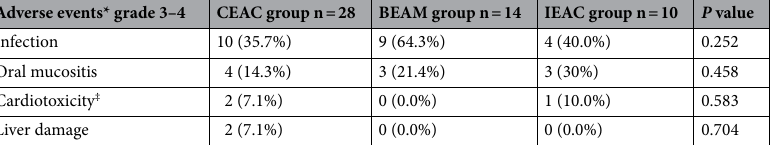
Table 3. TRAEs within 100 days after ASCT in CEAC, BEAM and IEAC groups. *Hematological adverse events were not included. ‡Two patients in the CEAC group died of cardiotoxicity.